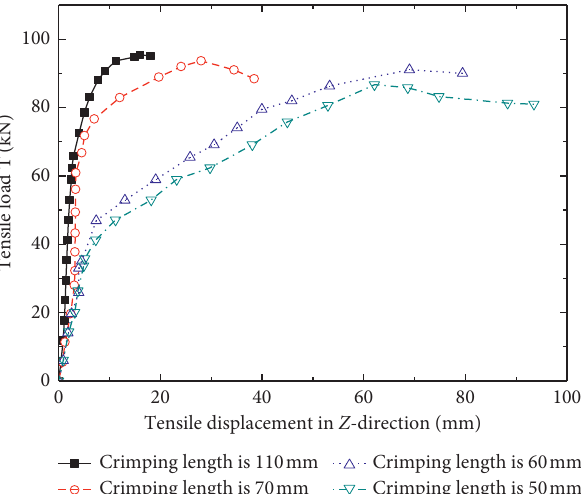
Figure 19: Comparison of the simulated tensile load-displacement curves of the strain clamp-conductor system under different crimping